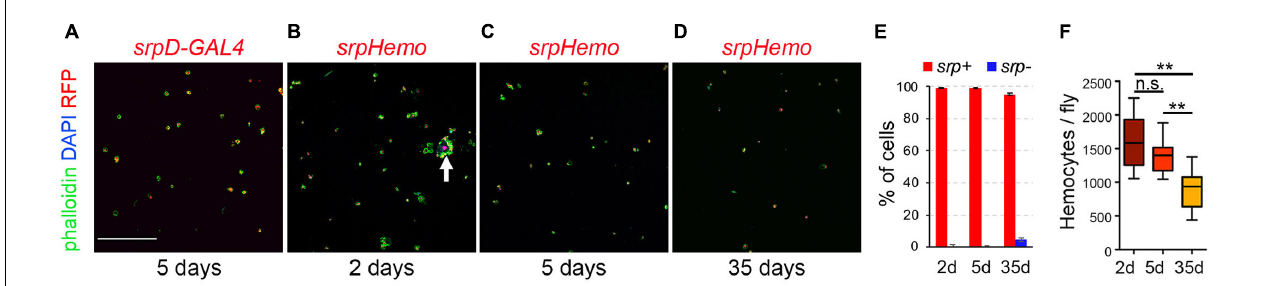
FIGURE 1 | Recovery of Drosophila blood cell by bleeding. (A–D) Confocal images of cells recovered from srpD-GAL4,UAS-mCherry ( A , srpD-GAL4 ) or srpHemo-His2A-RFP ( B–D , srpHemo ) adult females. Cells were counterstained with phalloidin (green) and DAPI (blue). The age of the flies is indicated below each panel. Scale bar: 200 µ m. The arrow in panel (B) indicates a fat body cell surrounded by hemocytes. (E) Quantifications of the proportion of cells (DAPI + ) expressing srpHemo-His2A-RFP according to fly age. Means and standard deviations of five independent experiments are shown. A total of 2316, 2351, and 1516 cells were counted in 2- day-, 5- day-, and 35-day-old flies, respectively. (F) Quantifications of the absolute number of cells recovered per fly at different ages. Means and standard deviations from eight independent experiments are represented. Kruskal–Wallis test was used for statistical analysis. n.s., non-significant ( p > 0.05); ** p < 0.01.